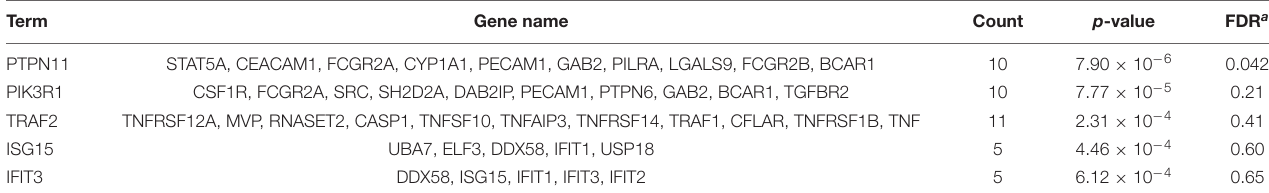
TABLE 1 | BioGRID interactome analysis of top 300 upregulated genes at 2 dpi. Term